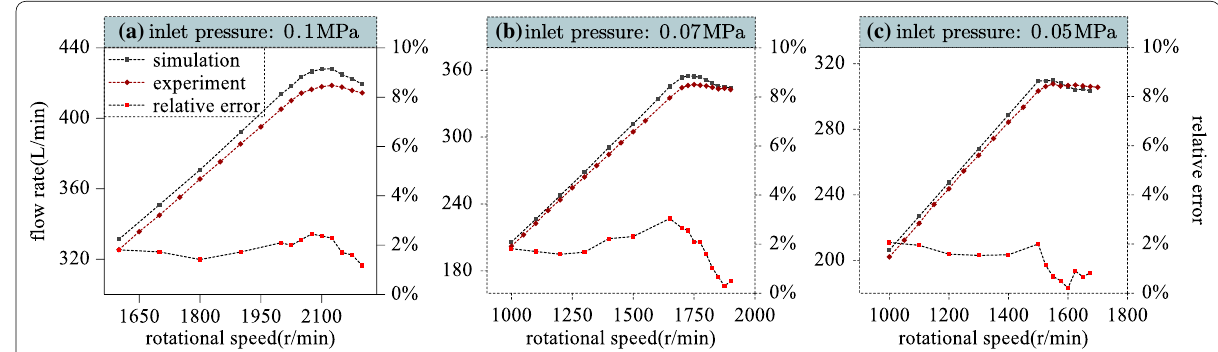
Figure 6 Simulation and experimental results of the delivery flow rate under different rotational